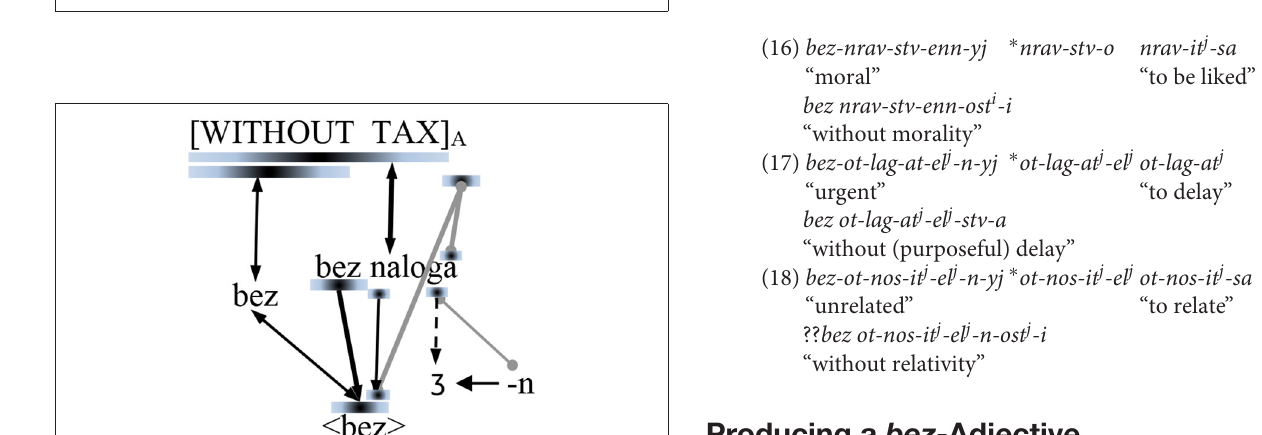
FIGURE 2 | Part of an associative network representing the planning of a novel bez- Adjective meaning “without tax(es)” without using complete words or phrases. Excitatory connections are black arrows; inhibitory ones are gray and end in circles. Gradients symbolize activation patterns over a distributed representation. Mutual inhibition and all schematic associations are shown by bidirectional connectors while syntagmatic associations are unidirectional arrows.